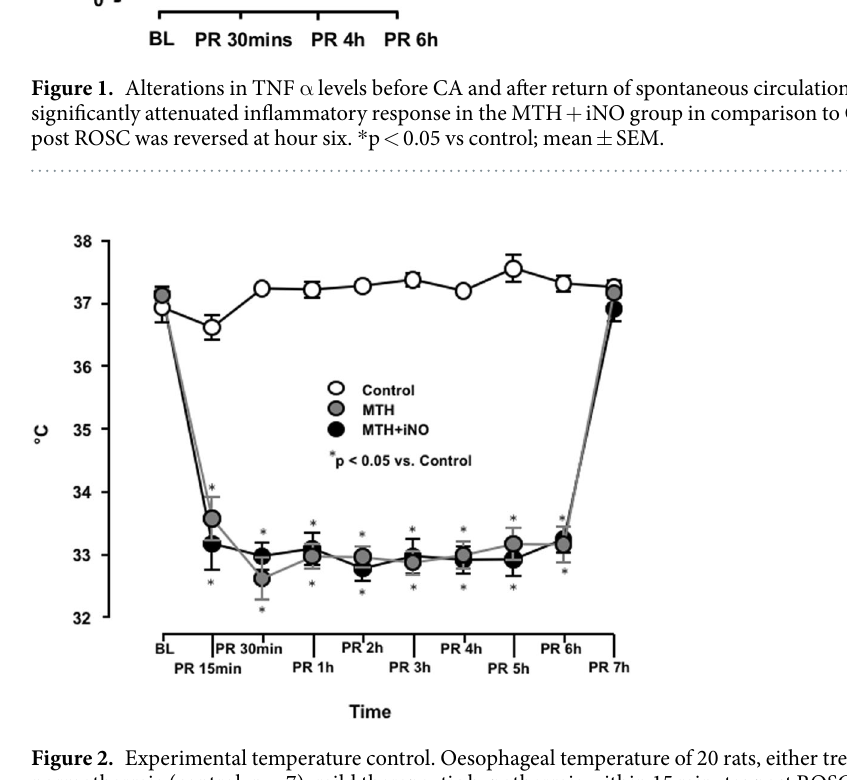
Figure 2. Experimental temperature control. Oesophageal temperature of 20 rats, either treated with normothermia (control, n = 7), mild therapeutic hypothermia within 15 minutes post ROSC for six hours (MTH, n = 6) or 20ppm iNO (MTH + iNO, n = 7) for five hours, starting 1 hour post ROSC in combination with MTH to baseline (BL) and post resuscitation (PR). * p < 0.05 vs control; mean ±